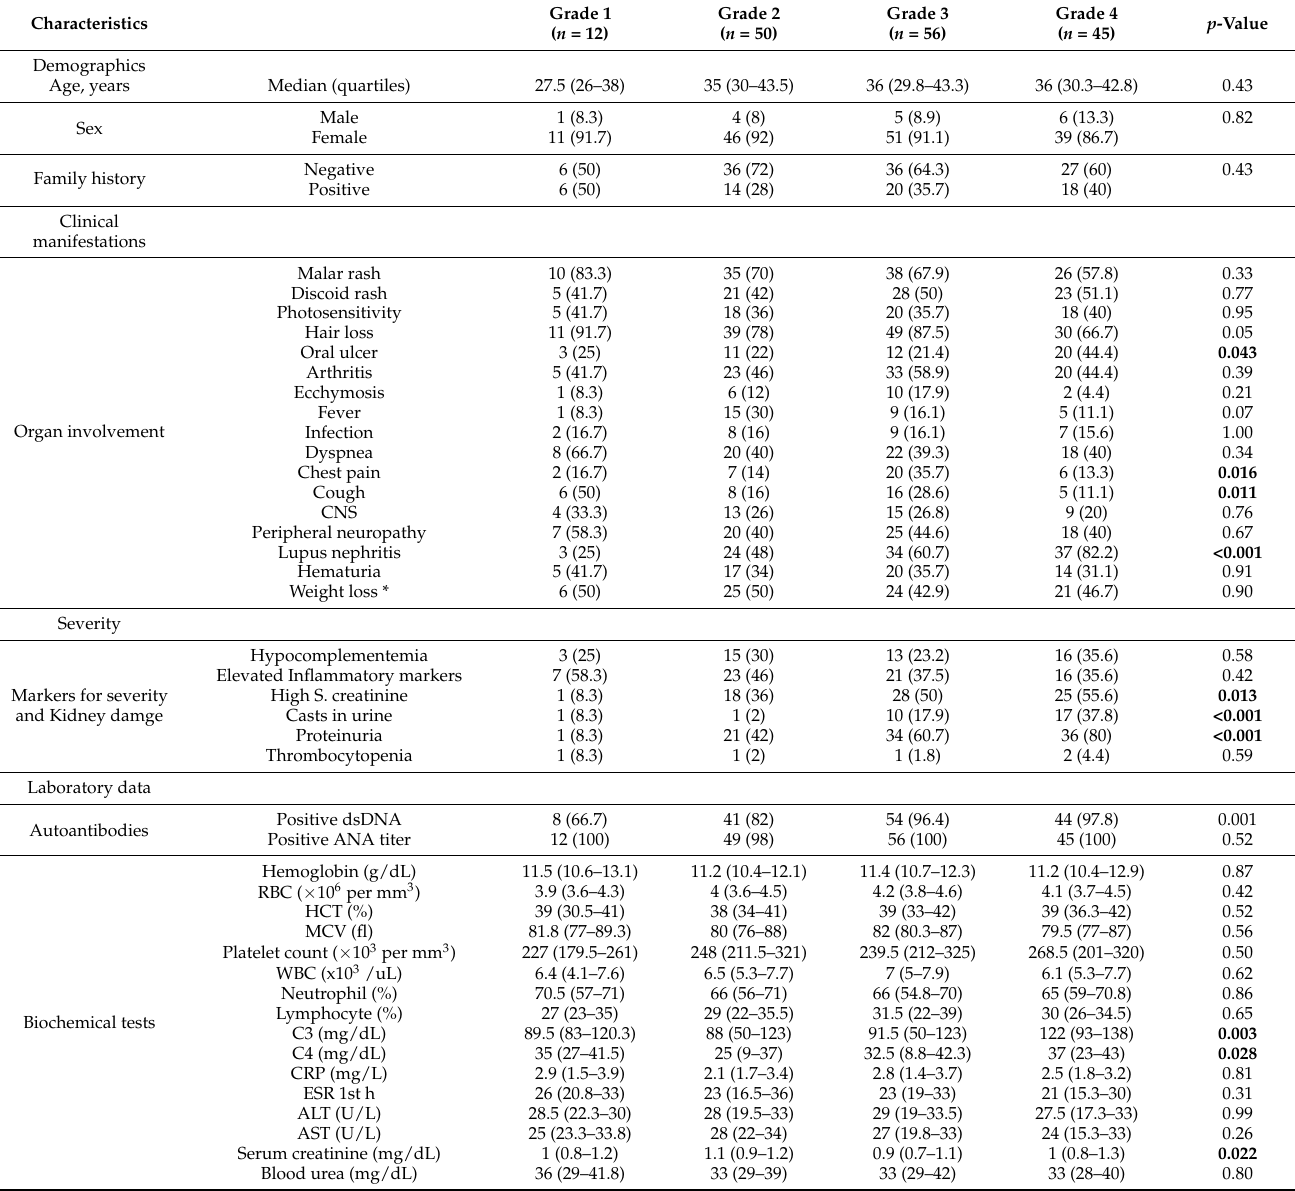
Table 2. Characteristics of SLE patients according to their disease